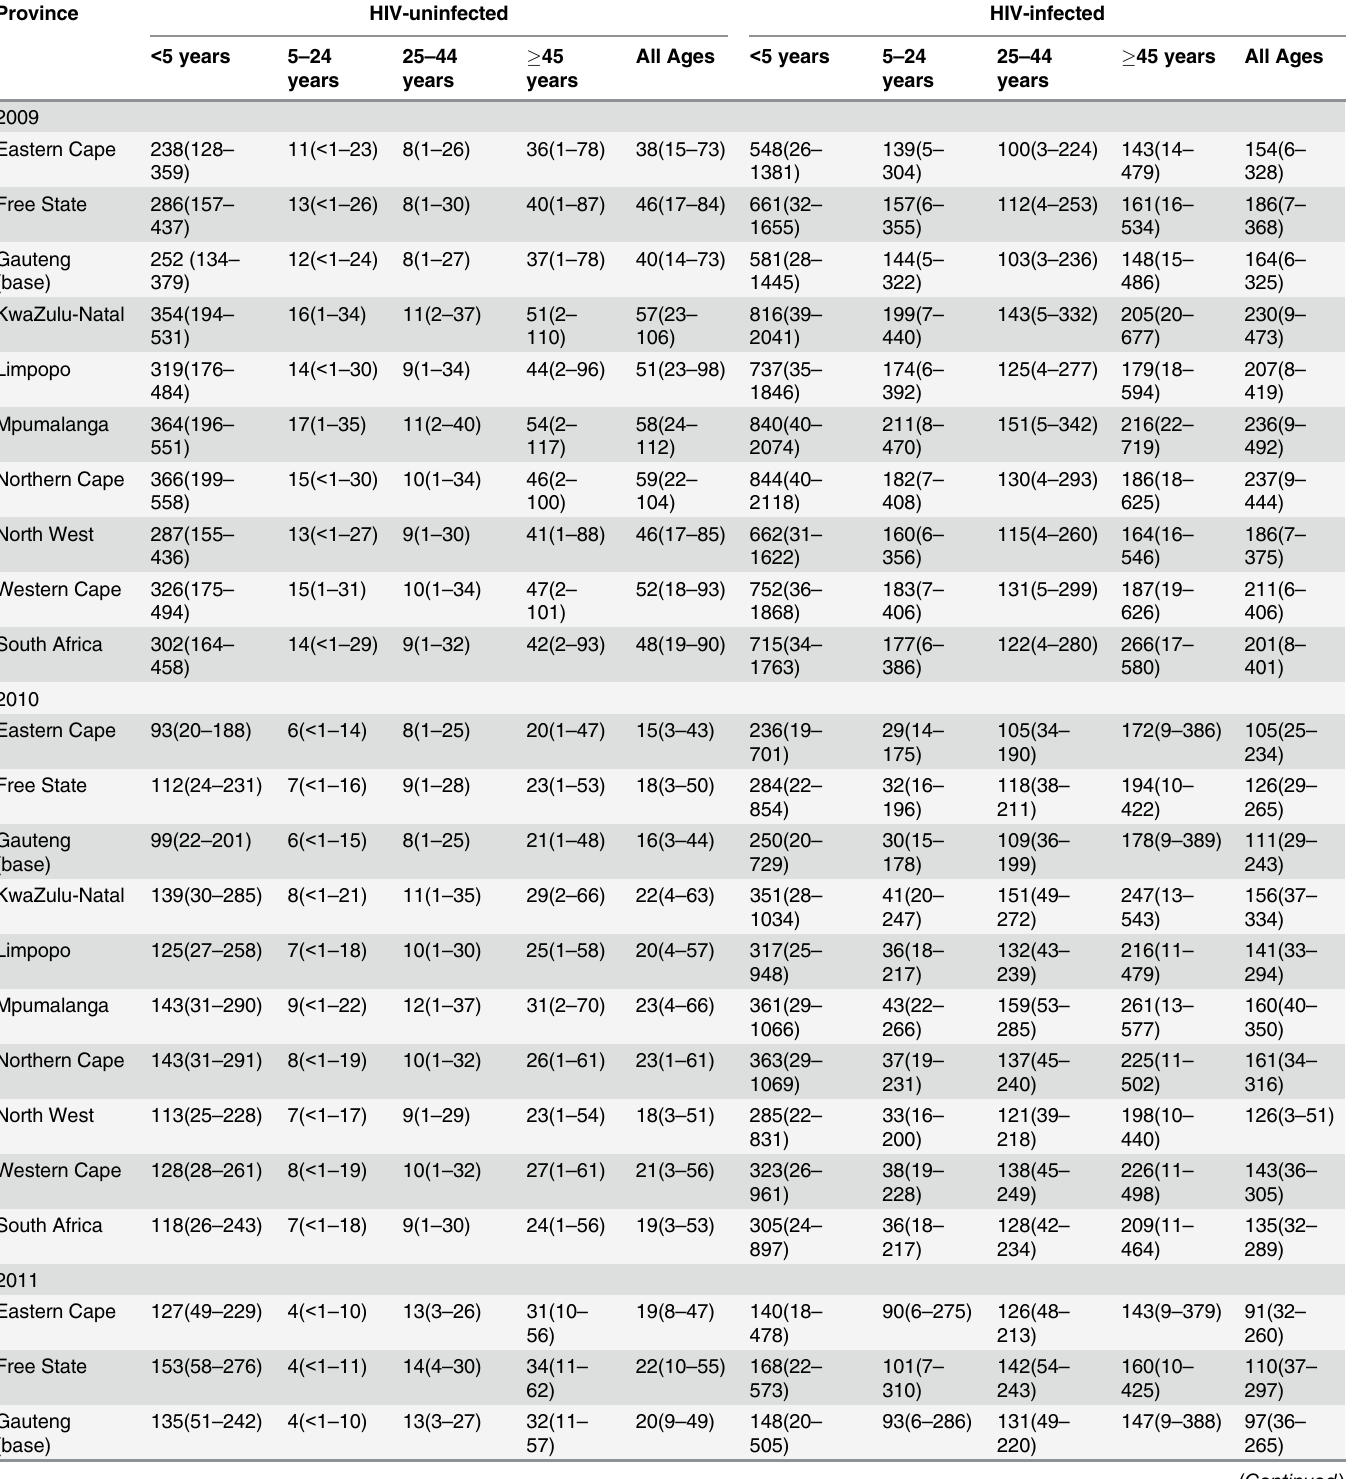
Table 1. Estimated hospitalized influenza-associated severe acute respiratory illness (SARI) incidence (95% C.I.), stratified by HIV serostatus for each province and nationally, South Africa, 2009 – 2011. Data are rates per 100,000